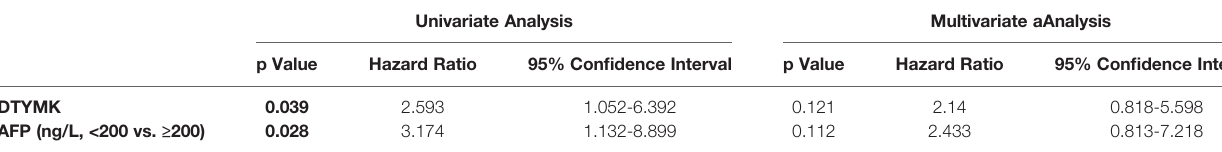
TABLE 4 | Univariate and multivariate analyses of various prognostic parameters in patients with HCC Cox-regression analysis.